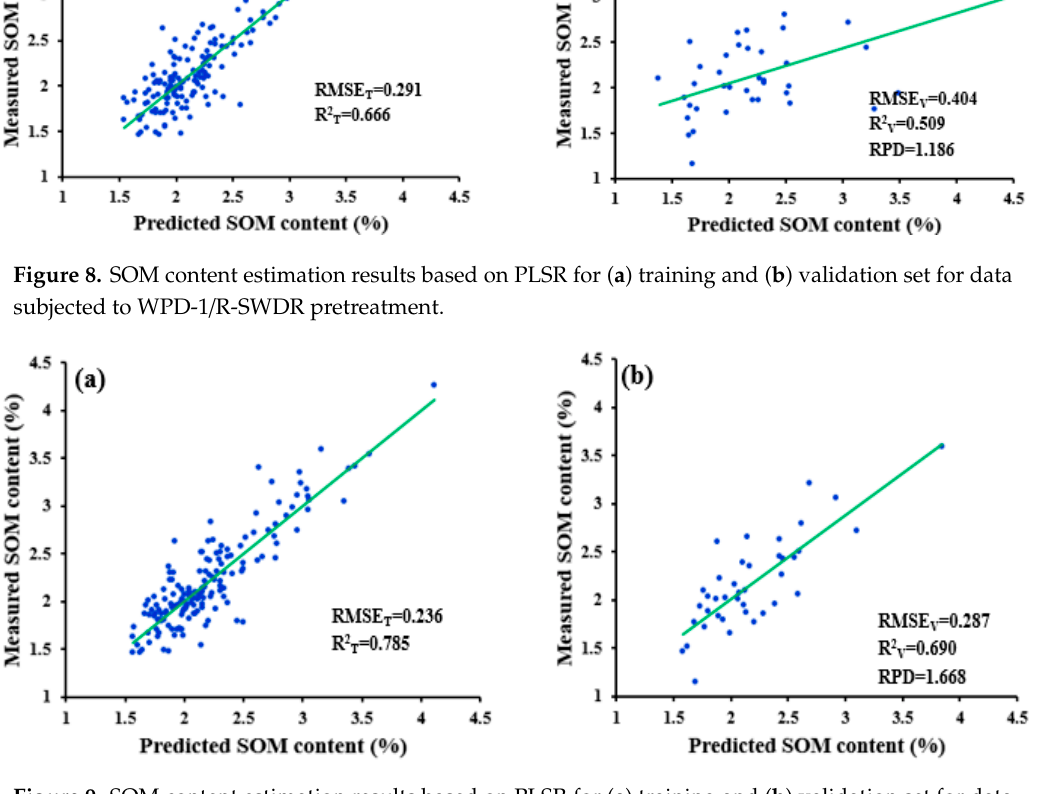
Figure 9. SOM content estimation results based on PLSR for ( a ) training and ( b ) validation set for data subjected to WPD-1/R-PCADR pretreatment.